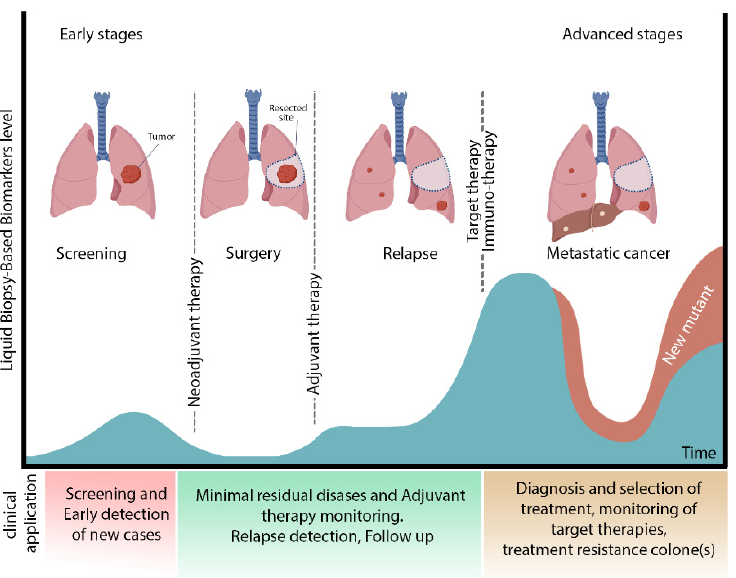
Figure 1. Different stages of lung cancer and clinical application of liquid biopsy. This figure shows the different stages of lung cancer. After surgery, the presence of MRD induces a recurrence. Immunotherapy or target therapy is recommended for treatment and management of relapse. Biosensors are functional for early detection at the screening stage besides identifying new mutants in the advanced cancer stage. Future aspects of biosensors are the assistance of select comprehensive therapy (adjuvant therapy) and monitoring lung cancer at different levels.